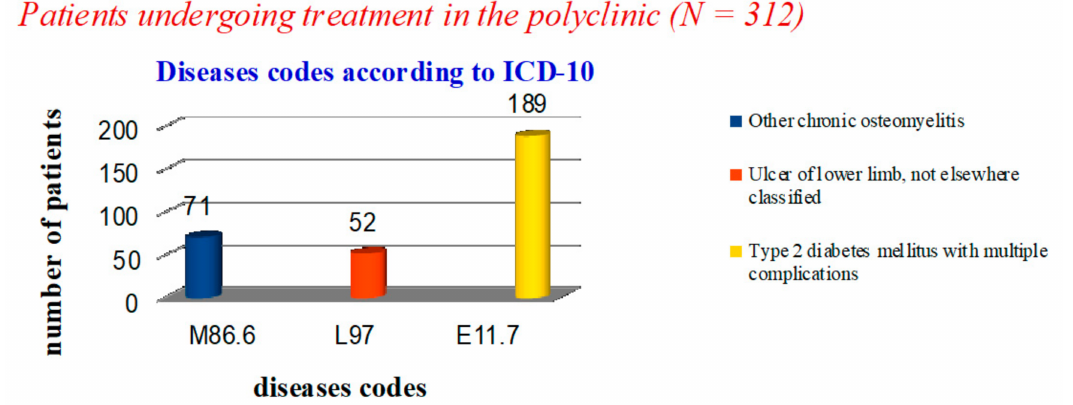
Figure 3. Statistical data on the nosology of patients treated in the polyclinic. After analysing cases of diabetic foot syndrome in the polyclinic, it was revealed that 97 patients had a diagnosis of Edf11.3.2—non-insulin-dependent diabetes mellitus with diabetic foot syndrome, trophic ulcer of the plantar surface of the foot in the projection of the metatarsophalangeal joints, with lesions of the skin and subcutaneous fat (49-r, 48-l). Eighty-four patients had trophic lesions of the first toe. The diagnosis was coded as Edf11.1. In 57 patients, the depth of the lesion reached the muscle layer (Edf11.1.3), of which 36 had the lesion on the right (r). The rest of the patients ( n = 131) had other trophic changes in the feet with varying depths of lesion (Figure 4).